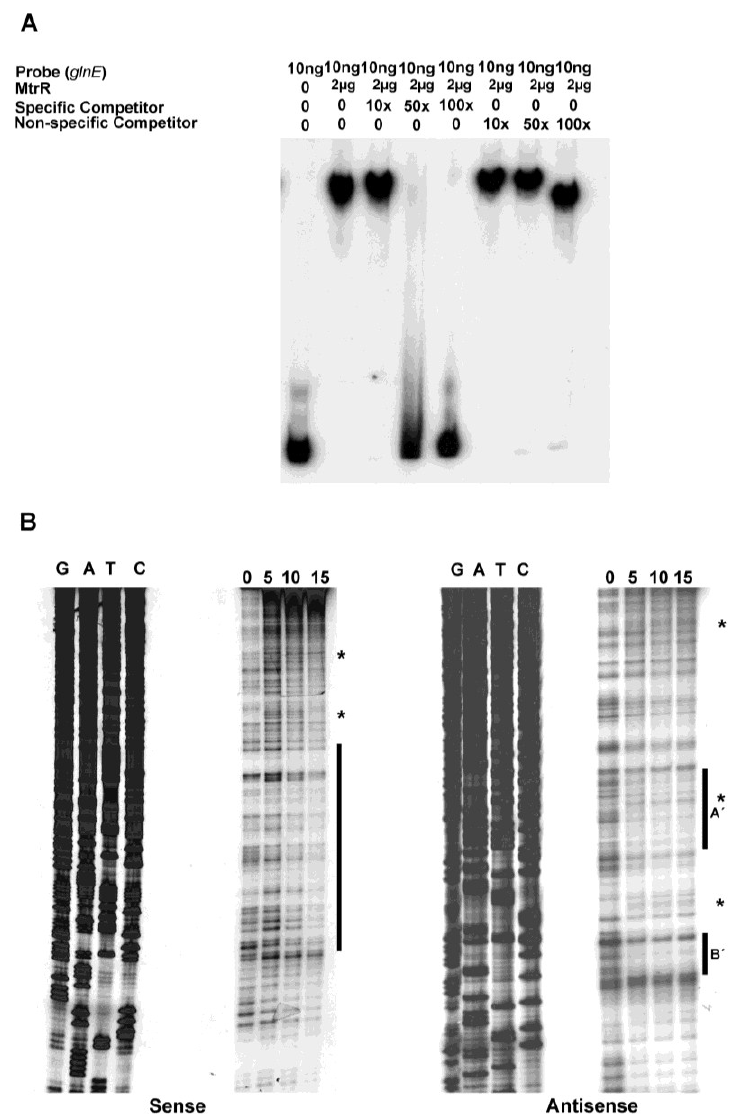
Figure 3. Identification of the MtrR-binding site in the glnE upstream DNA. ( A ) The binding specificity of MtrR for the DNA shown in Figure 1 was determined by competitive EMSA; ( B ) The MtrR-binding sites within this sequence were identified by DNase I protection assays that employed increasing amounts of purified MtrR-MBP (0, 5, 10, and 15 μg) with both sense and anti-sense probes. The protected regions on each probe are identified by the black bars and the two sites on the anti-sense strand are labeled as A′ and B′. Regions containing DNase I hypersensitive sites, which could contain more than one nucleotide, on the sense and antisense strands are denoted by * . The sequencing reactions for each probe are adjacent to the DNase I protection reactions and oriented G, A, T,